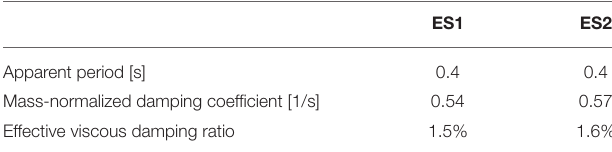
TABLE 2 | Summary of results for specimens ES1 and ES2 responses excited under design-level ground motions.